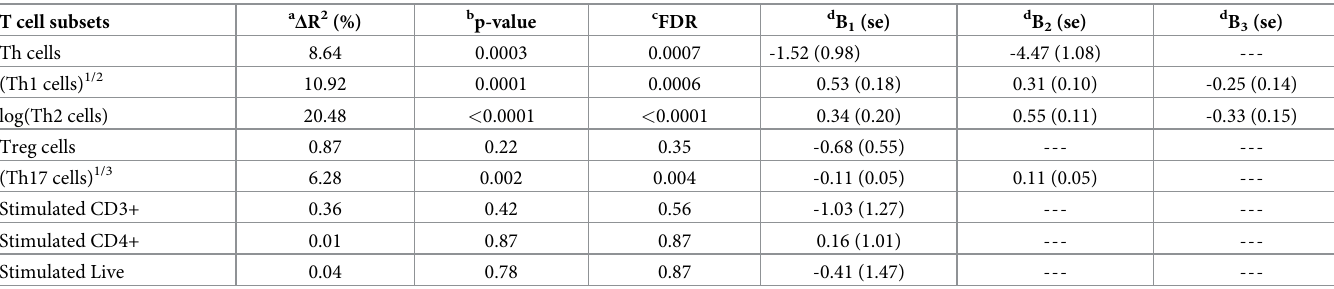
Table 5. Association between PAH-DNA adducts and T cell subsets (n = 180).